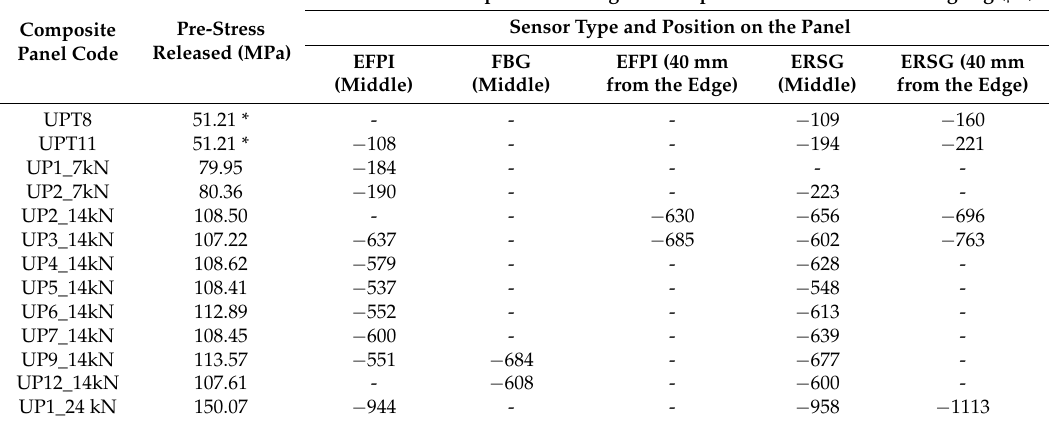
Table 5. Strain recorded from the EFPI, FBG and surface-mounted ERSG sensors when the pre-stress was released by unclamping the composite from the pre-stressing rig. The strain data were acquired at room temperature.